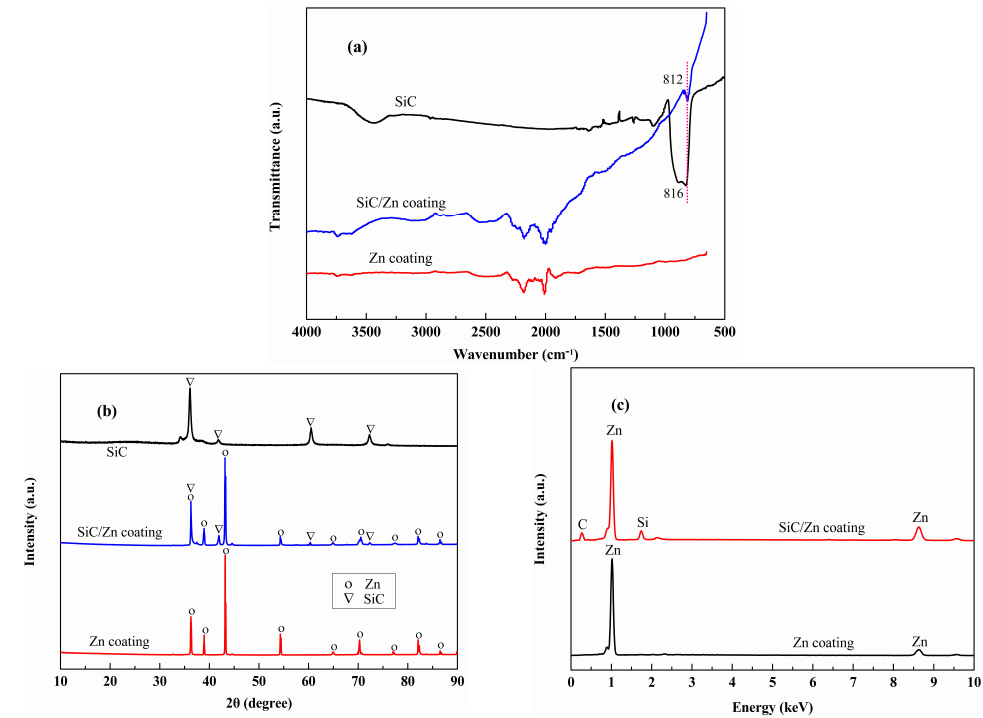
Figure 6. Structure analysis of Zn and SiC/Zn coatings: ( a ) FTIR spectra; ( b ) XRD patterns and ( c ) Energy dispersive spectrometer (EDS) spectra.